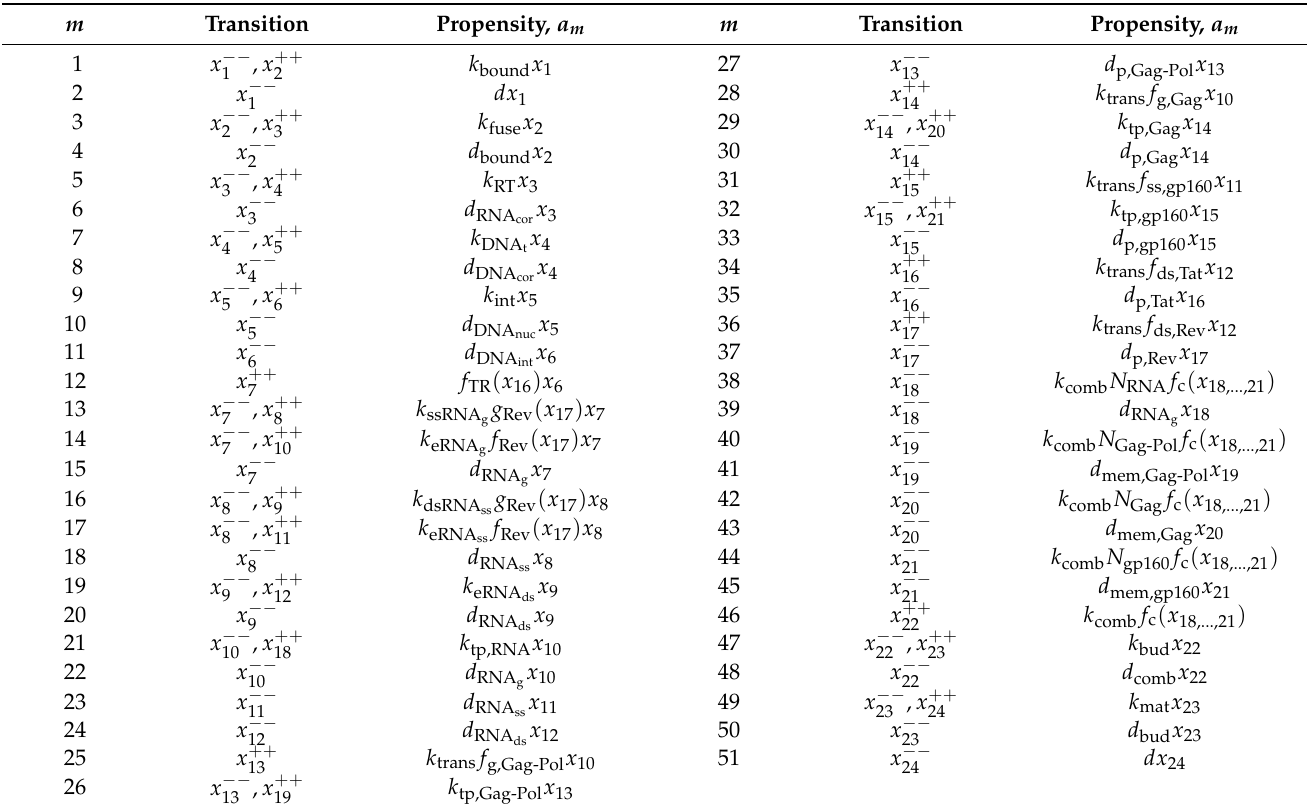
Table 1. Markov chain: the list of individual reactions m , the corresponding state transitions and the propensities of reactions which define the probabilities of the individual reactions to occur over a small time interval δ t .